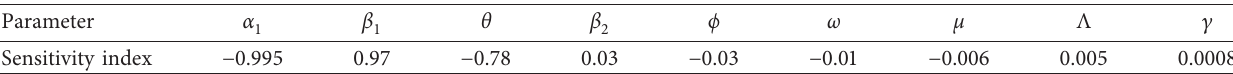
� 8 . 25 × 10 − 6 and β � 4 × 10 − 5 , and all the other model parameters are as in 1 2